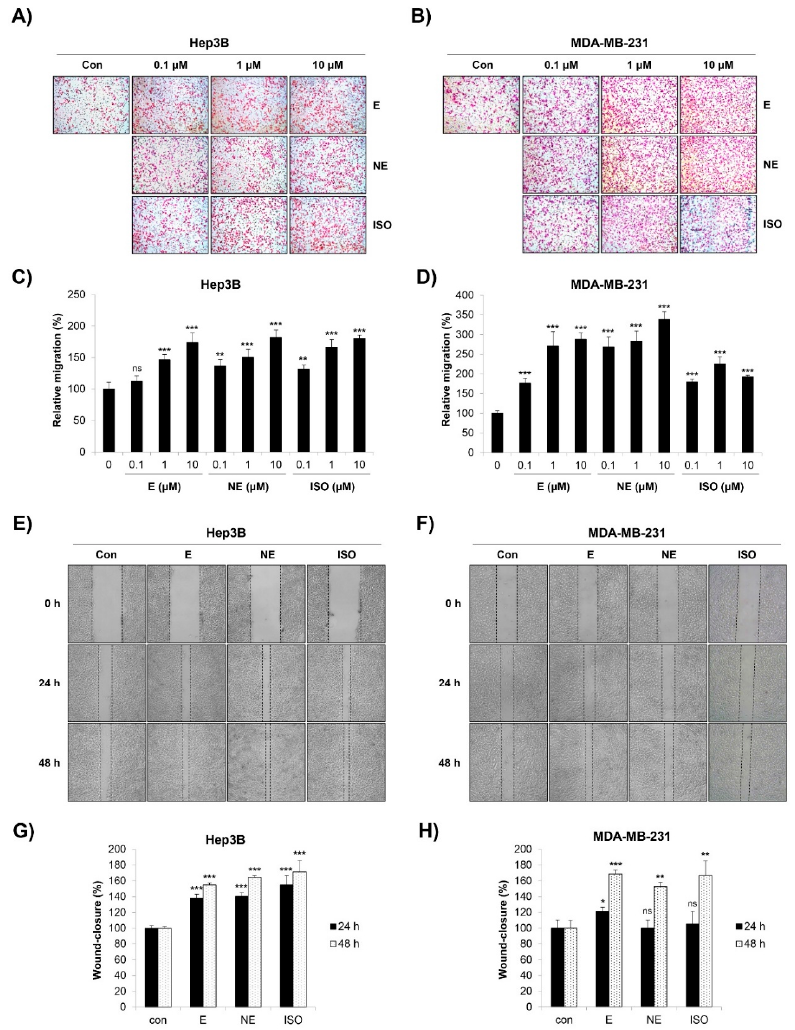
Figure 1. Effect of adrenergic agonists on the migration of Hep3B and MDA-MB-231 cells. ( A – D ) Hep3B human HCC cells ( A , C ) and MDA-MB-231 human BC cells ( B , D ) suspended in